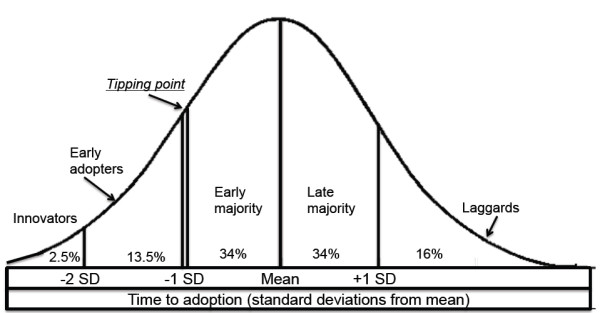
Dynamics of innovation spread [3],[4].